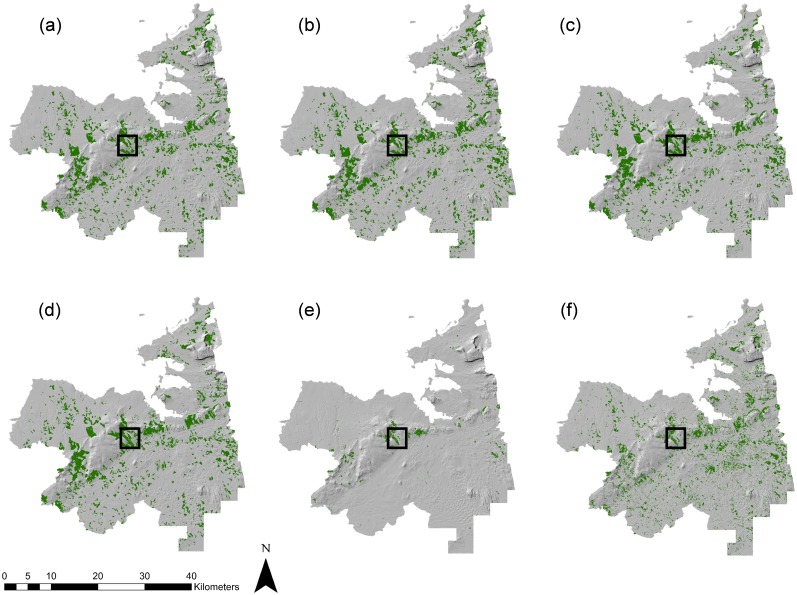
Extent of forest cover in Sligo based on (a) SAR RF-5, (b) SAR ERT-5, (c) Forestry2010, (d) Prime2, (e) JRC Forest Map 2006, and (f) Global Forest Change map.The boxed area indicates the zoom-in area shown in Fig 8.